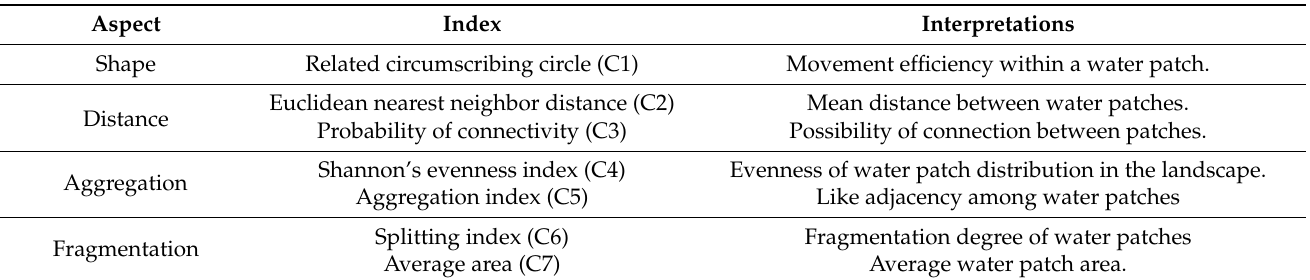
Table 2. Evaluation system for the wetland hydrological connectivity of Baiyangdian Lake (BYDL). Aspect Index Interpretations Shape Related circumscribing circle (C1) Movement efficiency within a water